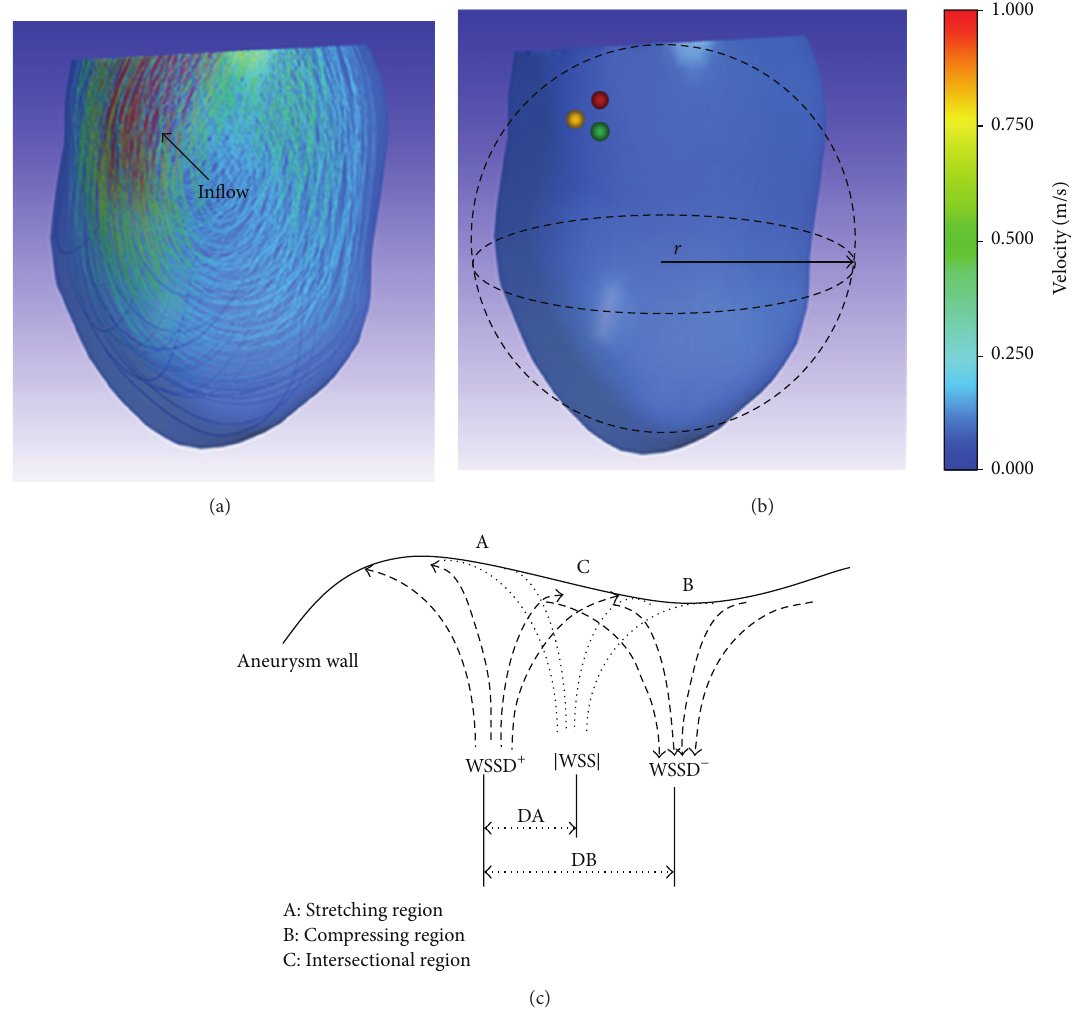
Figure 1: Inflow and stress centres. (a) Flow pattern. (b) Wave centres of WSSD and | WSS | ; red ball: the coordinate center of WSSD + , green ball: the coordinate center of WSSD − , and yellow ball: the coordinate center of | WSS | . (c) Different actions of WSSD + and WSSD − .